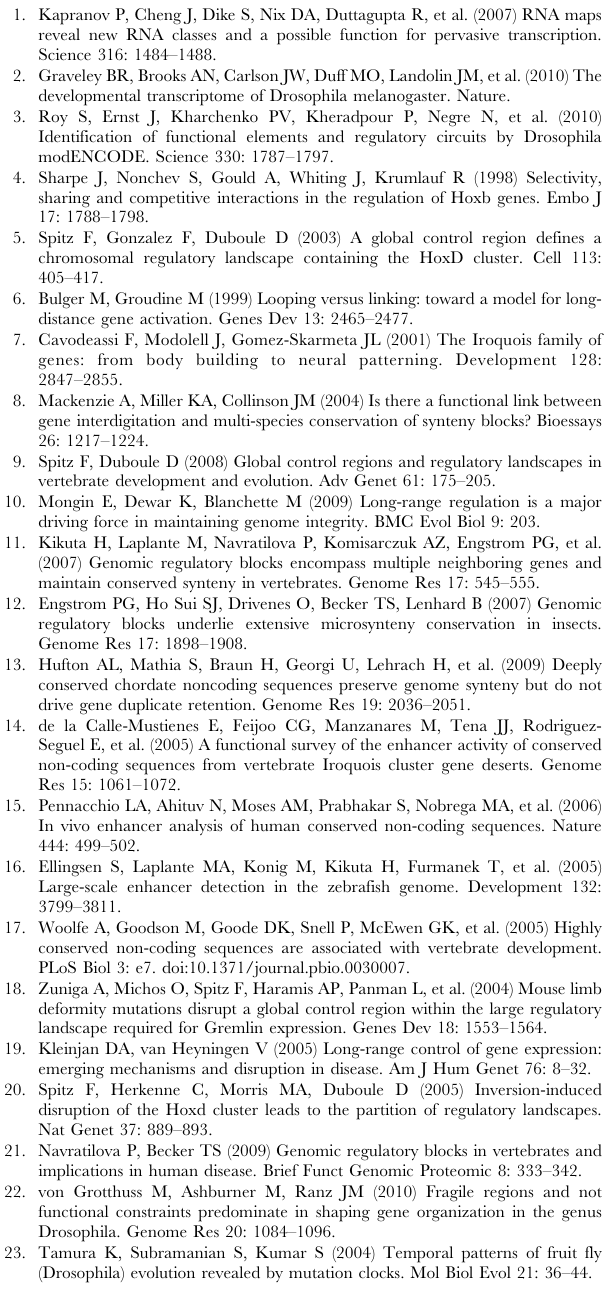
Table S19 Ability to detect significant differences between flies carrying the ultraconserved region CG15121–CG1689 in its disrupted or intact form across some of the experiments performed. Table S20 Number of tRNA, rRNA, and snoRNA genes in the ultraconserved region CG15121–CG16894 with potential to mediate NAHR